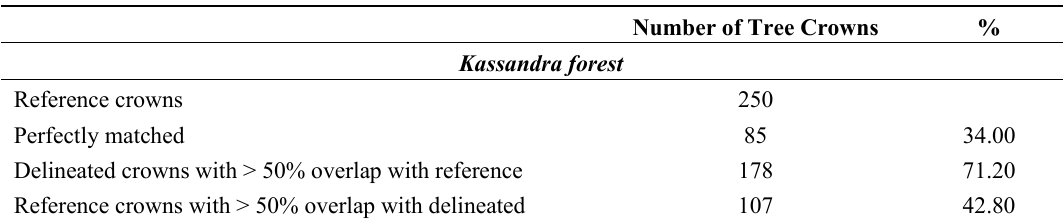
Table 2. Accuracy assessment results of the extracted tree crowns for the Kassandra and Thessaloniki